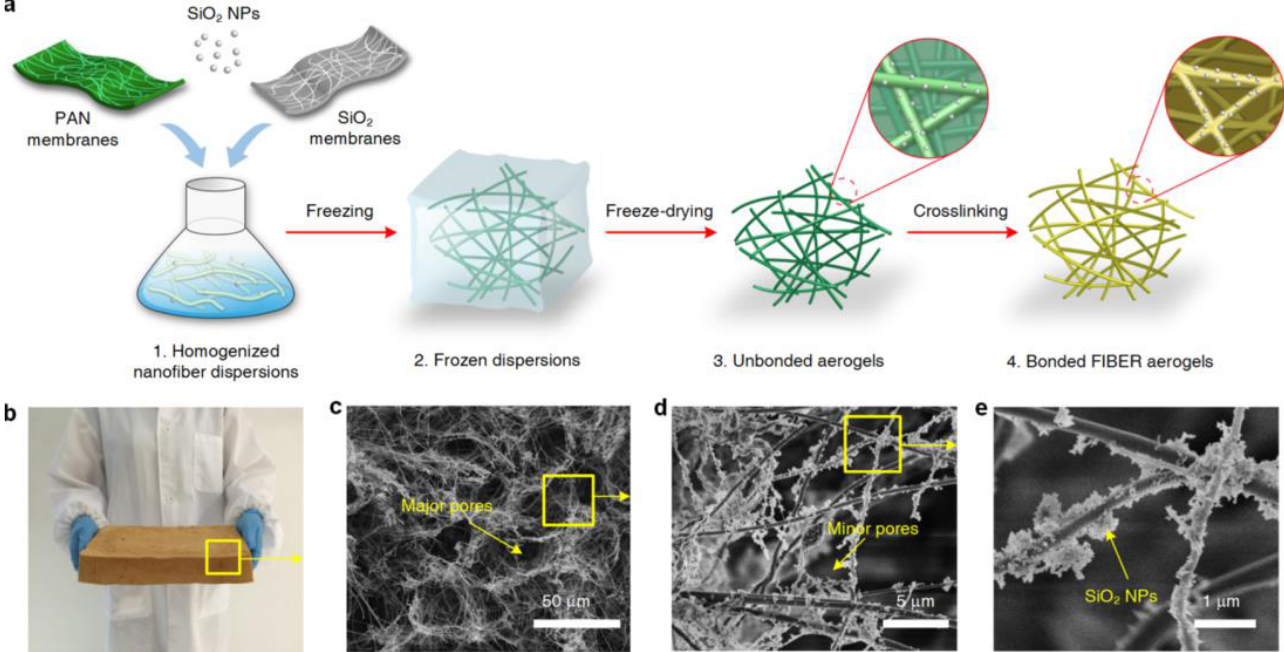
Figure 12. ( a ) Schematic showing the synthetic aerogel steps; ( b ) Optical image of fiber aerogel on a large scale of 2.5 L; ( c – e ) Microscopic architecture of fiber aerogels at various magnifications; Y. Si et al., “Superelastic and Superhydrophobic Nanofiber -Assembled Cellular Aerogels for Effective Separation of Oil/Water Emulsions” , ACS Nano, vol. 9, no. 4, pp. 3791 – 3799, 2015,